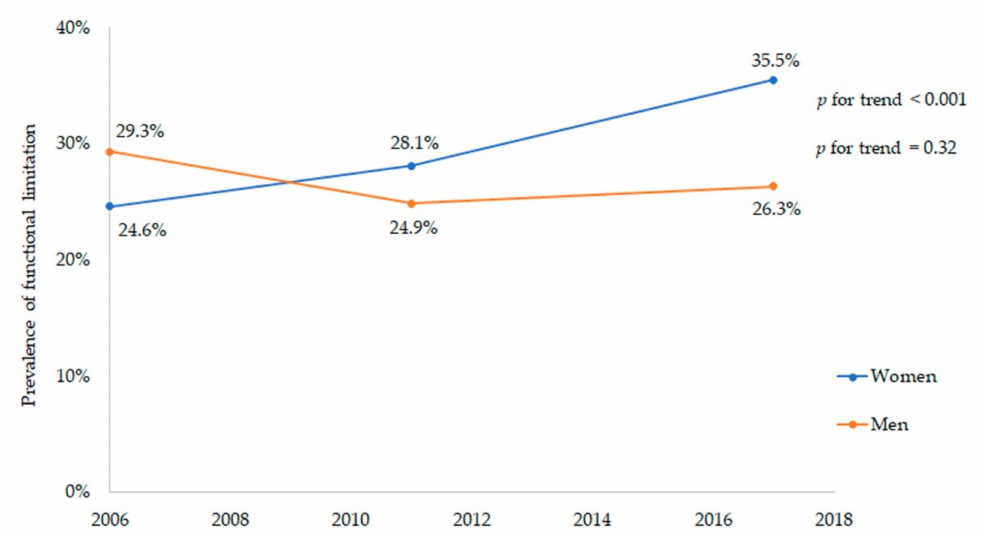
Figure 1. Prevalence of functional limitation in COPD patients over time ( n =